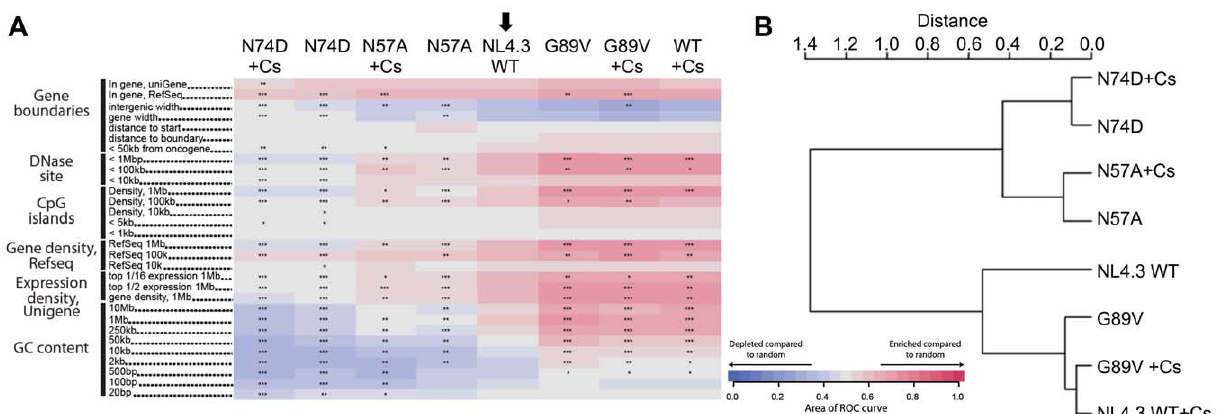
Figure 5. CypA inhibition alters HIV-1 integration site targeting. A , Effects of CypA inhibition by cyclosporine (Cs) on integration frequency near multiple chromosomal features for wild type NL4.3 HIV-1 GFP vector and CA mutants. The arrow denotes the wild type control set used for pairwise statistical comparisons to the other data sets. The heat map analysis was performed as in Figure 4A. B , ROC area values were used to generate pairwise Euclidean distances, which were then analyzed by hierarchical clustering generating the presented